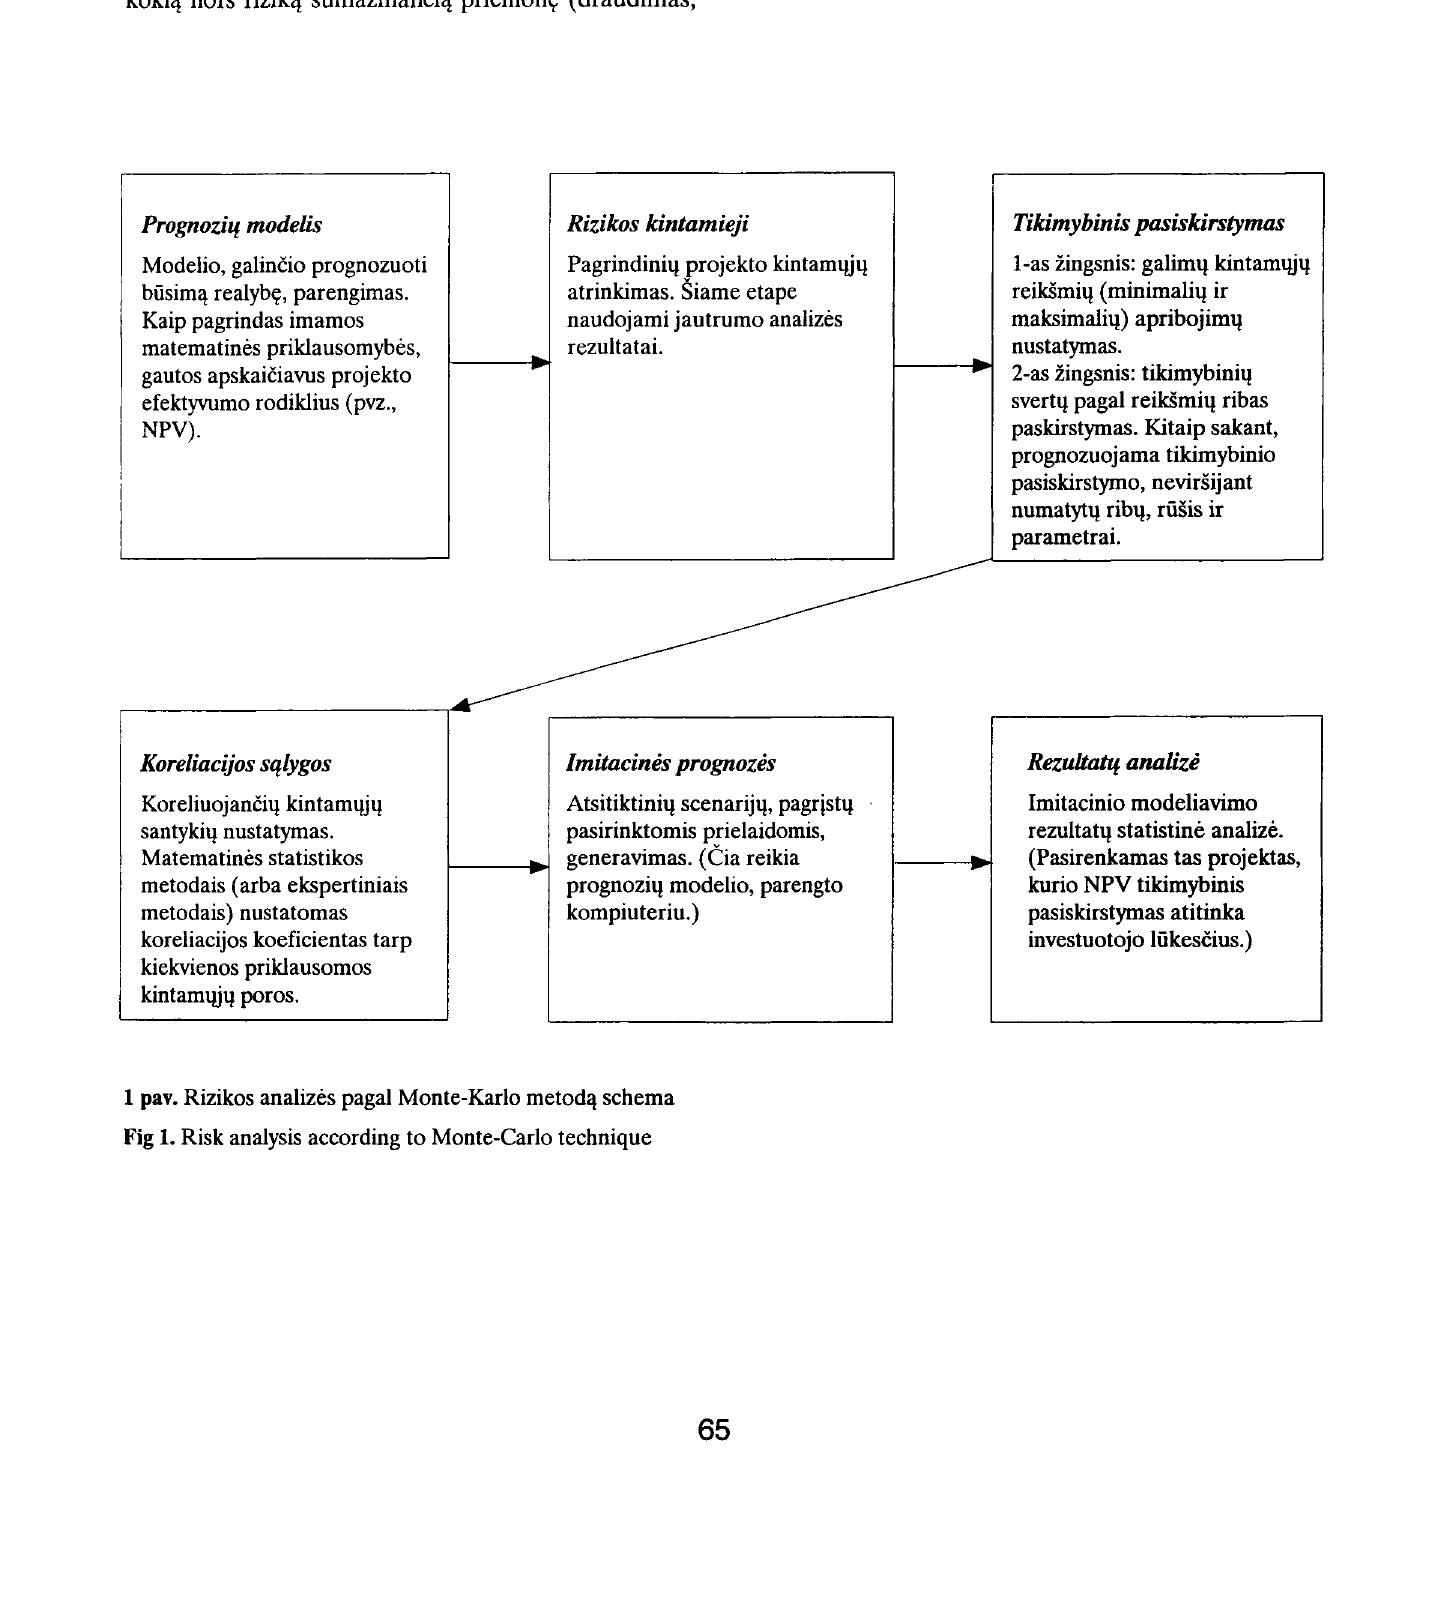
Fig 1. Risk analysis according to Monte-Carlo